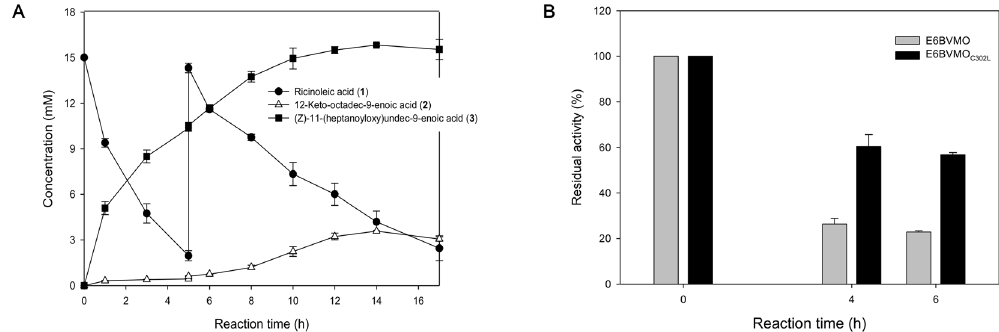
Figure 5. Time course of the biotransformation of ricinoleic acid by the recombinant E . coli BL21(DE3) pAPTm-E6BVMO C302L -ADH, expressing the ADH of M . luteus and the engineered E6BVMO (i.e., E6BVMO C302L ) ( A ) and the in vitro activity of E6BVMO C302L , which was prepared from the cells at t = 0, 4, and 6 h during the biotransformation shown in ( A,B ). The whole-cell biotransformation was conducted at the same condition as the biotransformation shown in Fig. 1. The in vitro activity of E6BVMO C302L at t = 0 was 0.050 U/mg proteins. Symbols indicate the concentrations of ricinoleic acid ( 1 ) ( ● ), 12-keto-octadec-9-enoic acid ( 2 ) ( △ ), and the ester ( 3) ( ■ ). The experiments were performed in triplicate. The error bars indicate standard